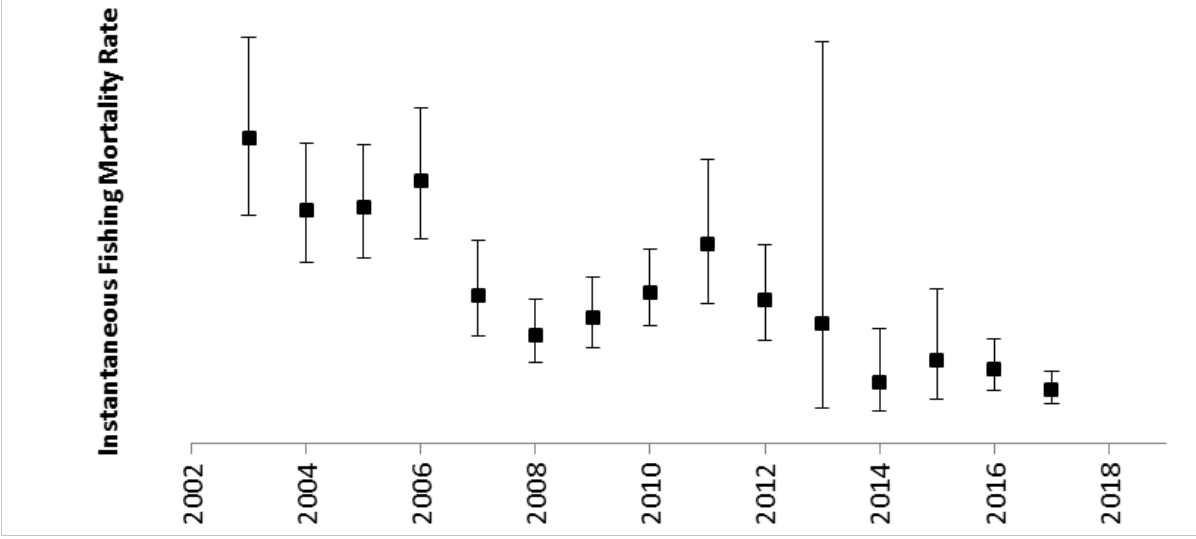
Figure 109. CMSA model estimated instantaneous fishing mortality rate F with lower and upper 95% confidence limits. Y-axis values have been removed due to CONFIDENTIAL